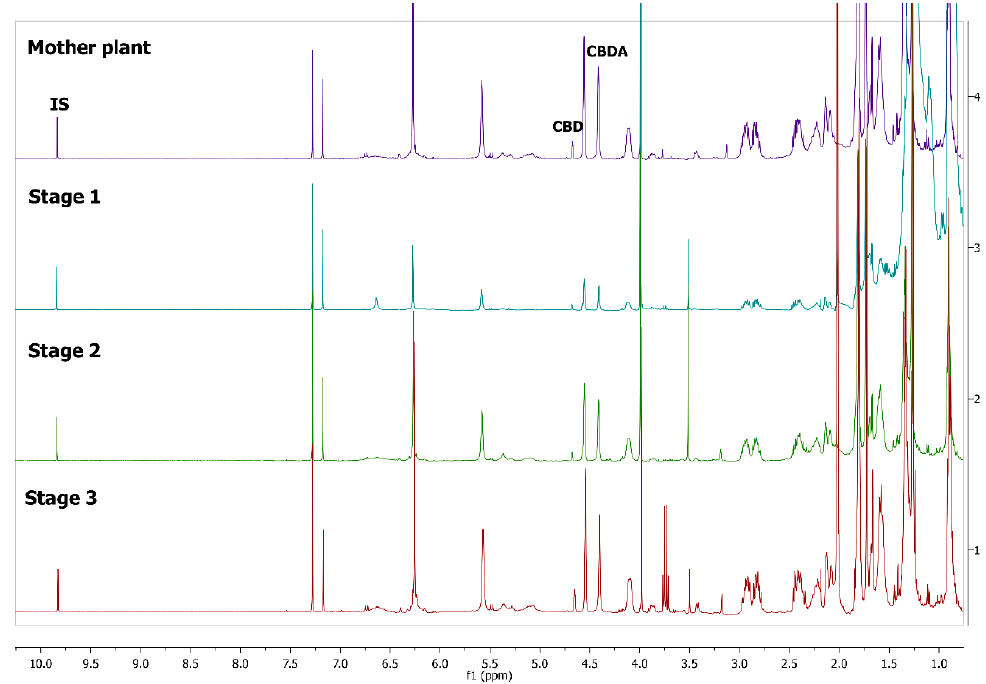
Figure 1. 1 H-NMR spectra of mother plant with high concentration in cannabidiolic acid (CBDA) (top) and in vitro cultivated plants in three stages of growth.